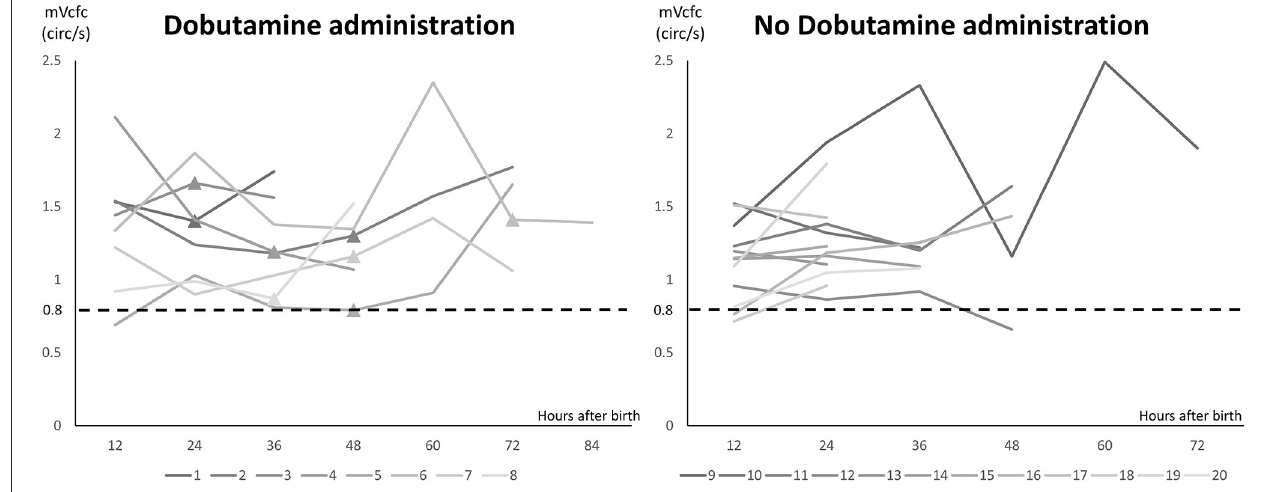
FIGURE 2 | Longitudinal values of mVcfc in the management group. Twenty cases were divided into two subgroups: 8 cases with Dobutamine administration and 12 cases without Dobutamine administration. X-axis showed hours after birth, and Y-axis showed the value of mVcfc. N stood for the timing of initiating Dobutamine administration.